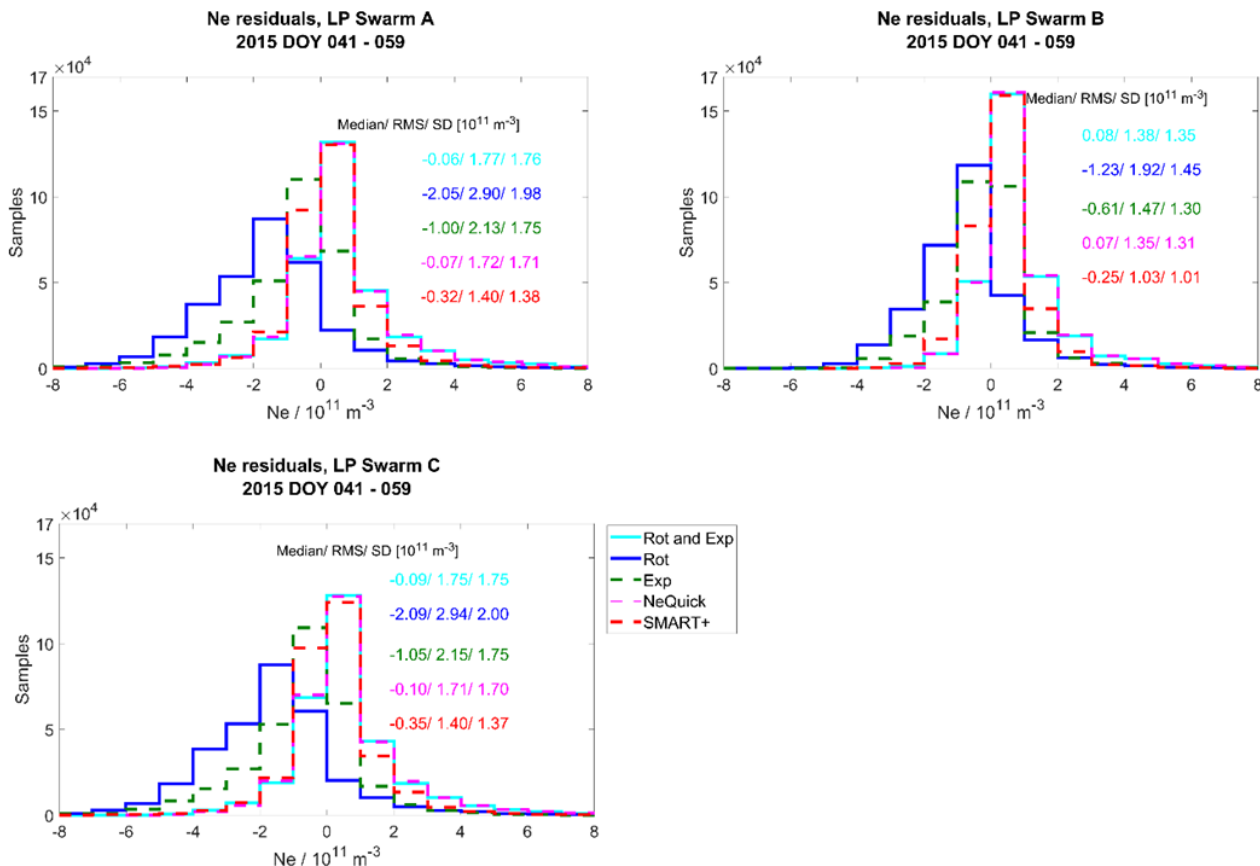
Figure 17. Validation with LP data. Distribution of Swarm A, B and C (separated) electron density residuals for the quiet period.